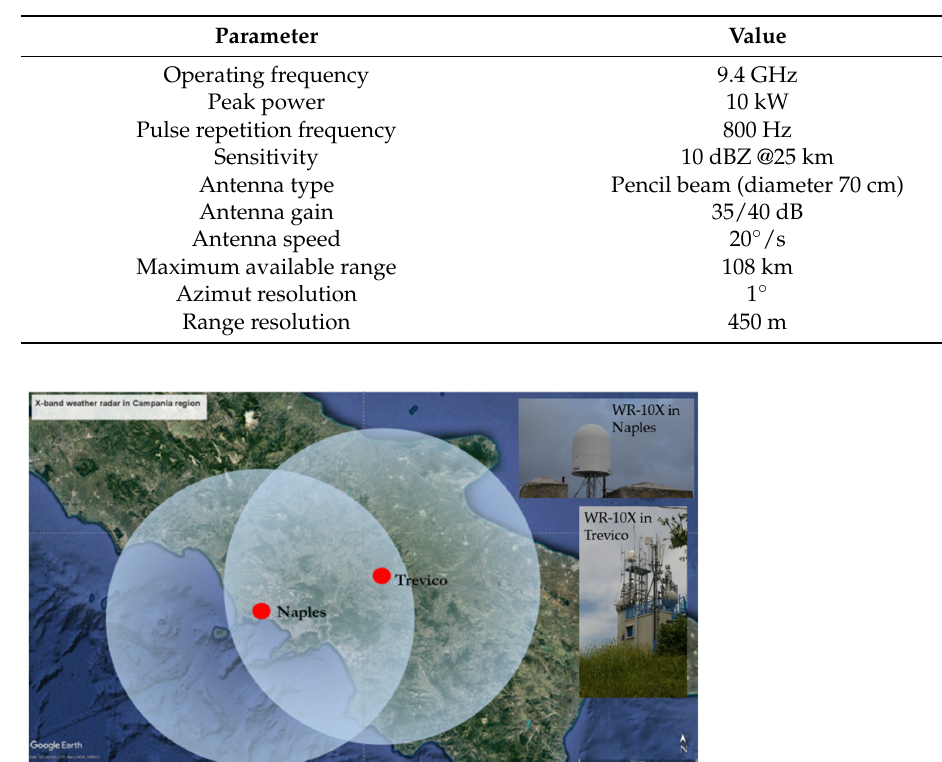
Table 1. Technical specifications of the WR-10X radar.